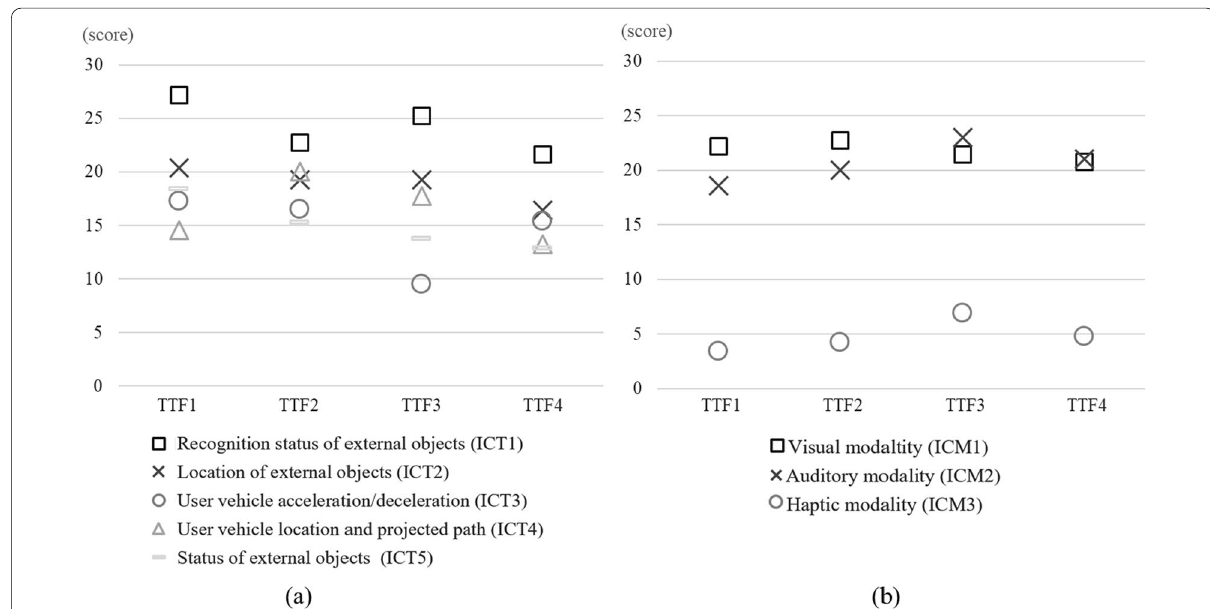
Fig. 3 TTF-specific a necessity level means according to provided information configuration types and b necessity level means according